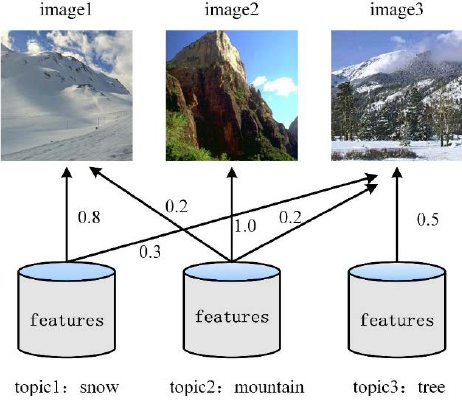
Figure 3. The schematic of the topic representation of the images.